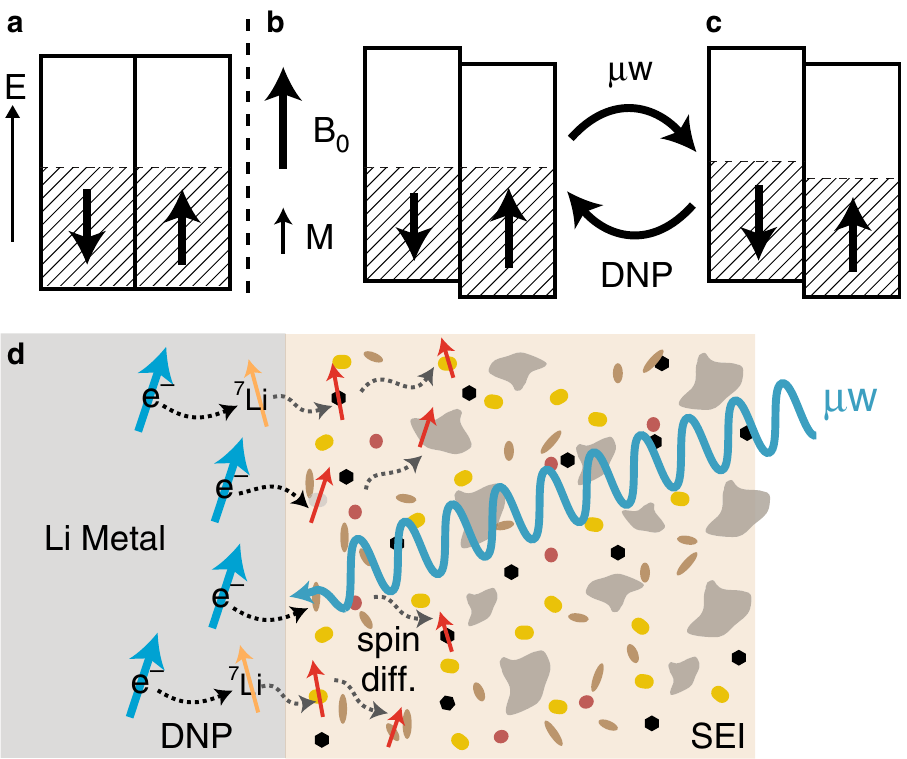
Fig. 1 The mechanism of Li metal DNP. a – c The conduction electron spin-bands of a metal, plotted against energy ( E ): a in the absence of a magnetic fi eld; b in an applied magnetic fi eld (B 0 ), resulting in a Pauli paramagnetic moment (M); and c after microwave ( μ w) irradiation at the CESR frequency. Note that the arrows for each spin-band represent the electron magnetic moment, not the electron spin which is opposite in sign. d Schematic of hyperpolarisation of lithium metal on application of microwaves (DNP, black dashed arrows) and subsequent spin diffusion in the heterogenous mixed organic/inorganic SEI (grey dashed